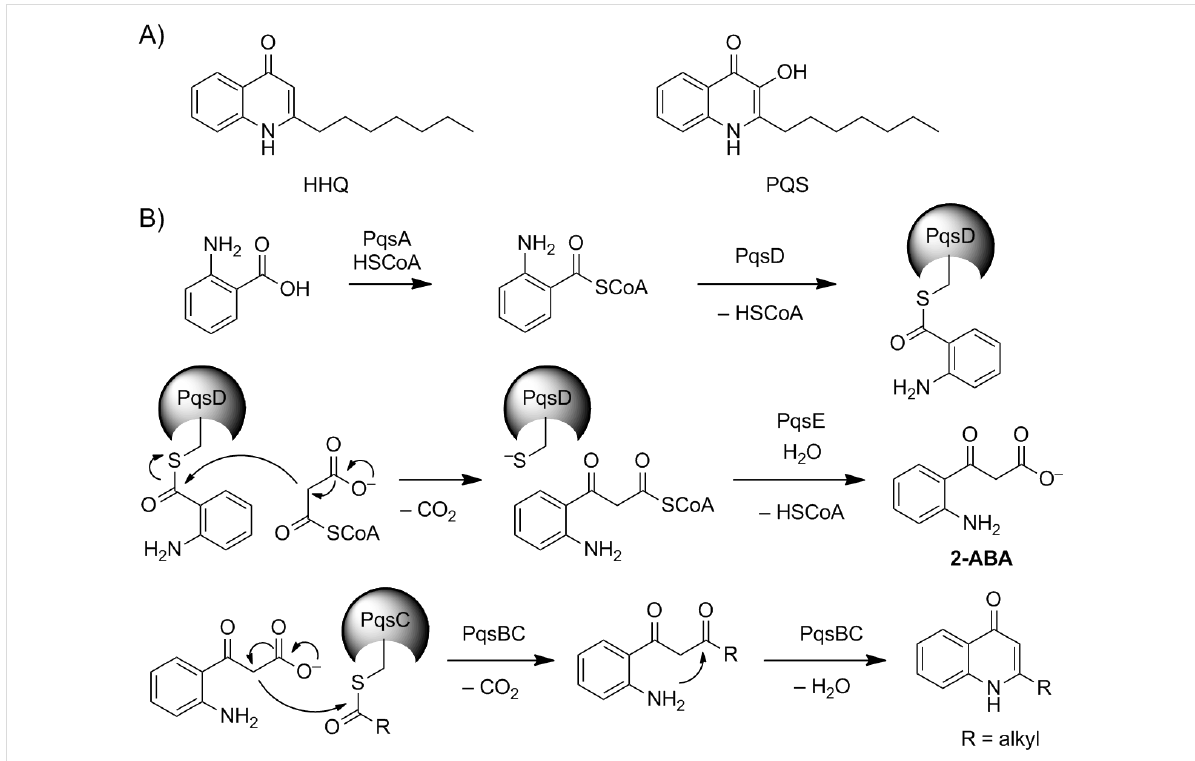
Figure 1: Quinolone signals of Pseudomonas aeruginosa . A) Structures of HHQ and PQS. B) Proposed mechanism for the synthesis of 2-alkyl-4- quinolones